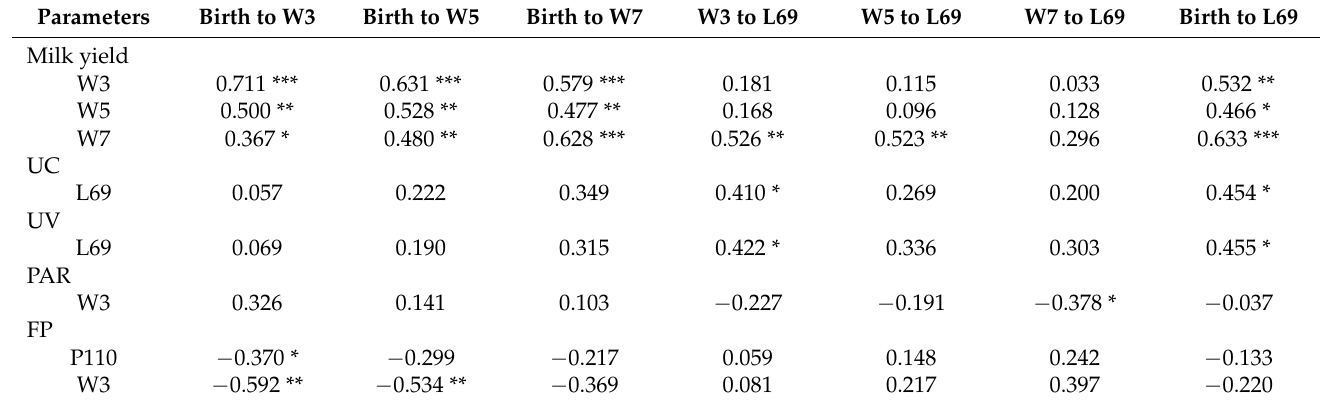
Table 7. Correlation coefficients of residuals of lamb growth from birth to week 3 (Birth to W3), birth to week 5 (Birth to W5), birth to week 7 of lactation (Birth to W7), W3 to weaning (W3 to L69), W5 to weaning (W5 to L69), W7 to weaning (W7 to L69), birth to weaning (Birth to L69), total daily milk yield in W3, W5 and W7, udder circumference (UC), udder volume (UV) at weaning (L69), the average of both udder halves of parenchyma (PAR) at W3 and fat pad (FP) at P110 and